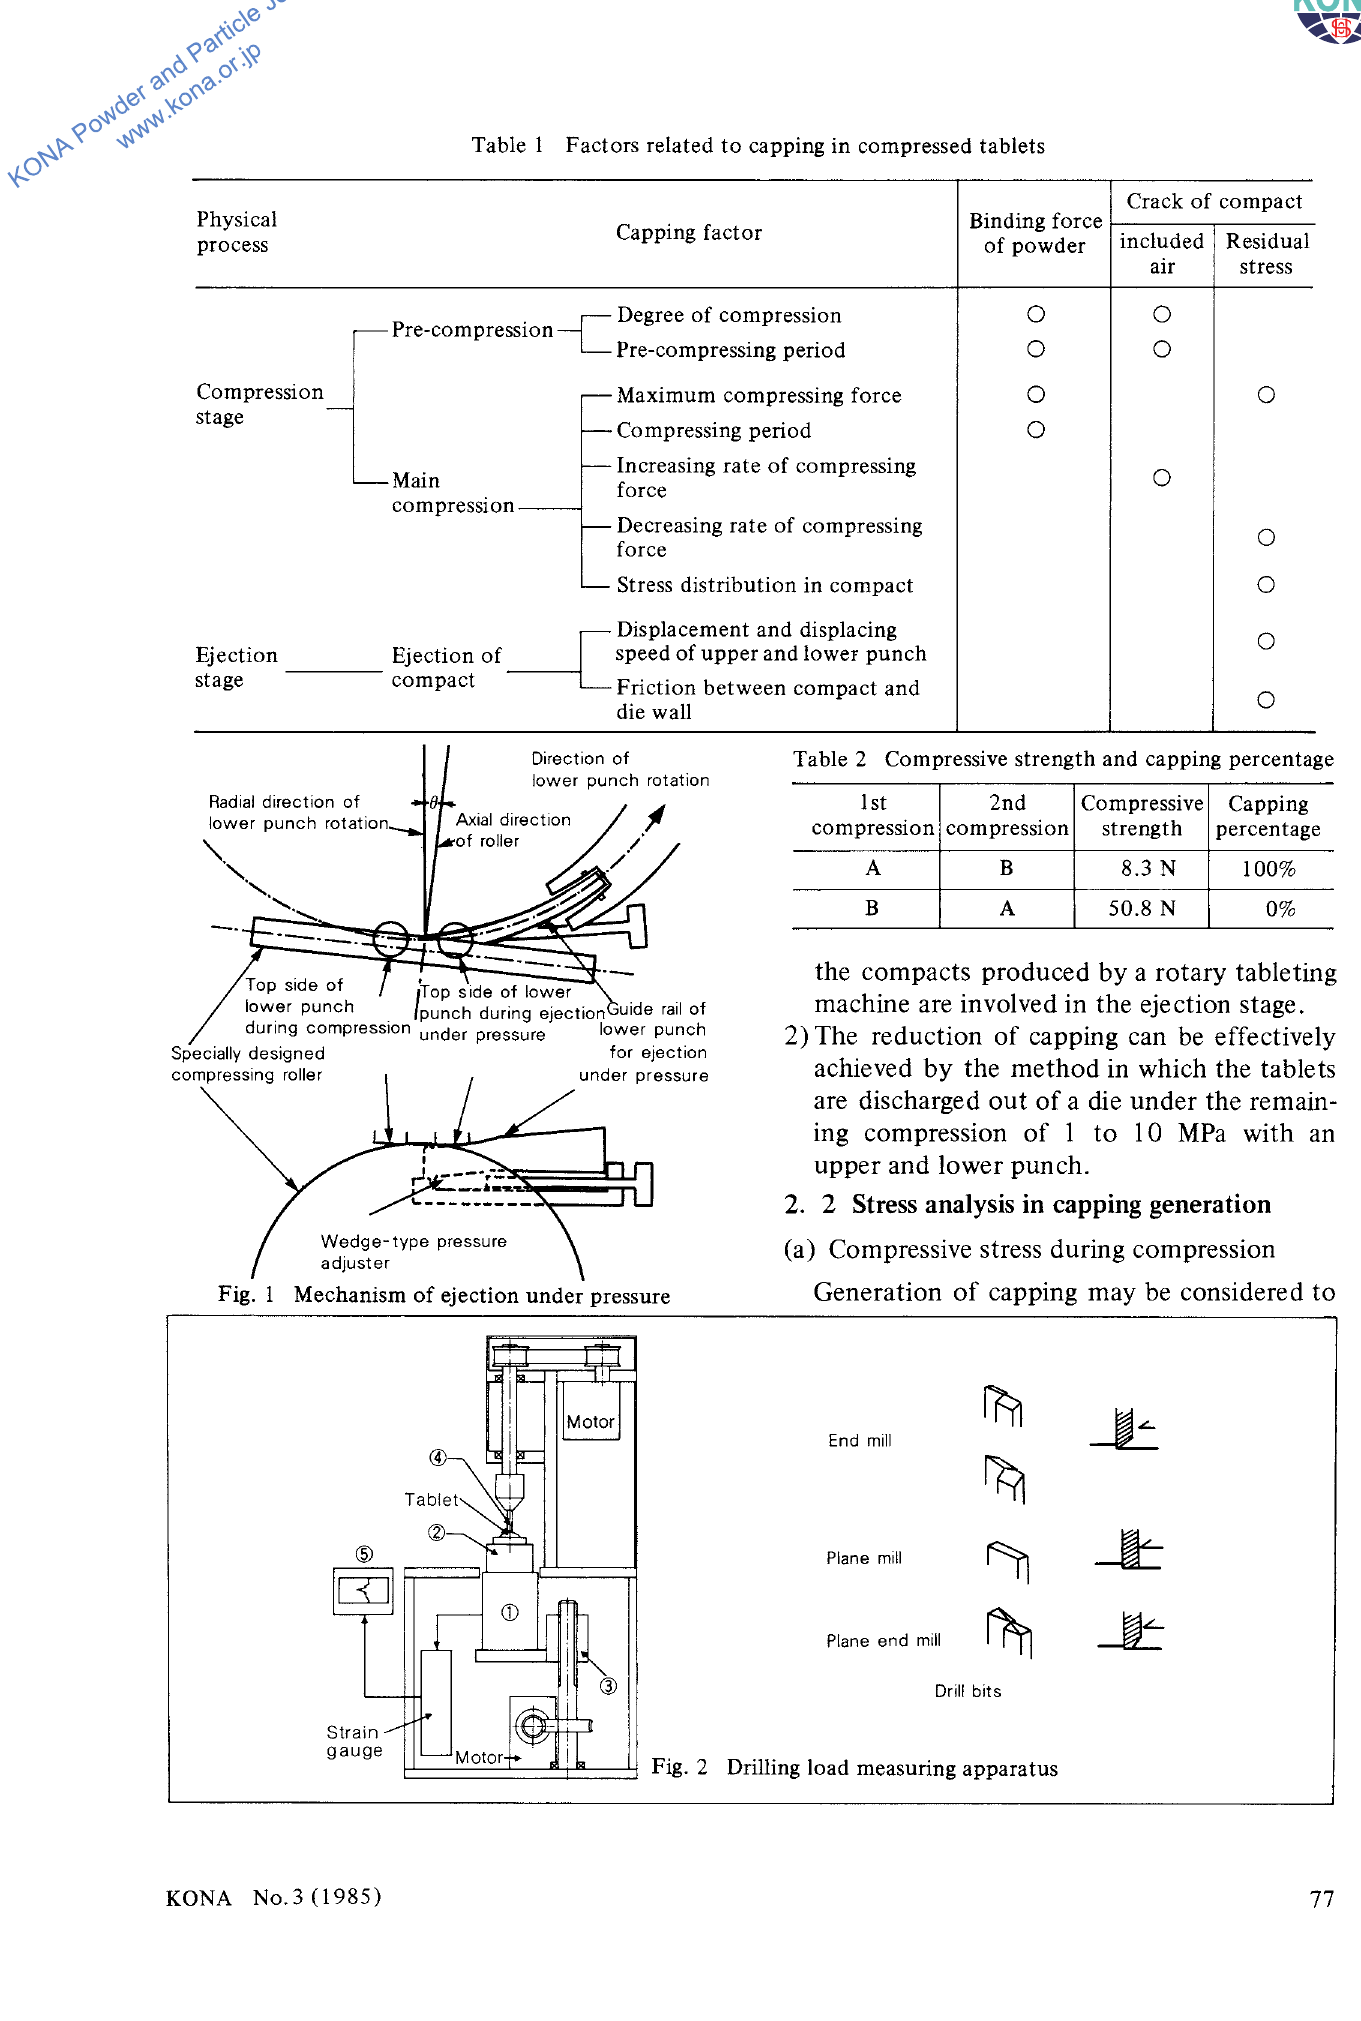
Fig. 2 Drilling load measuring